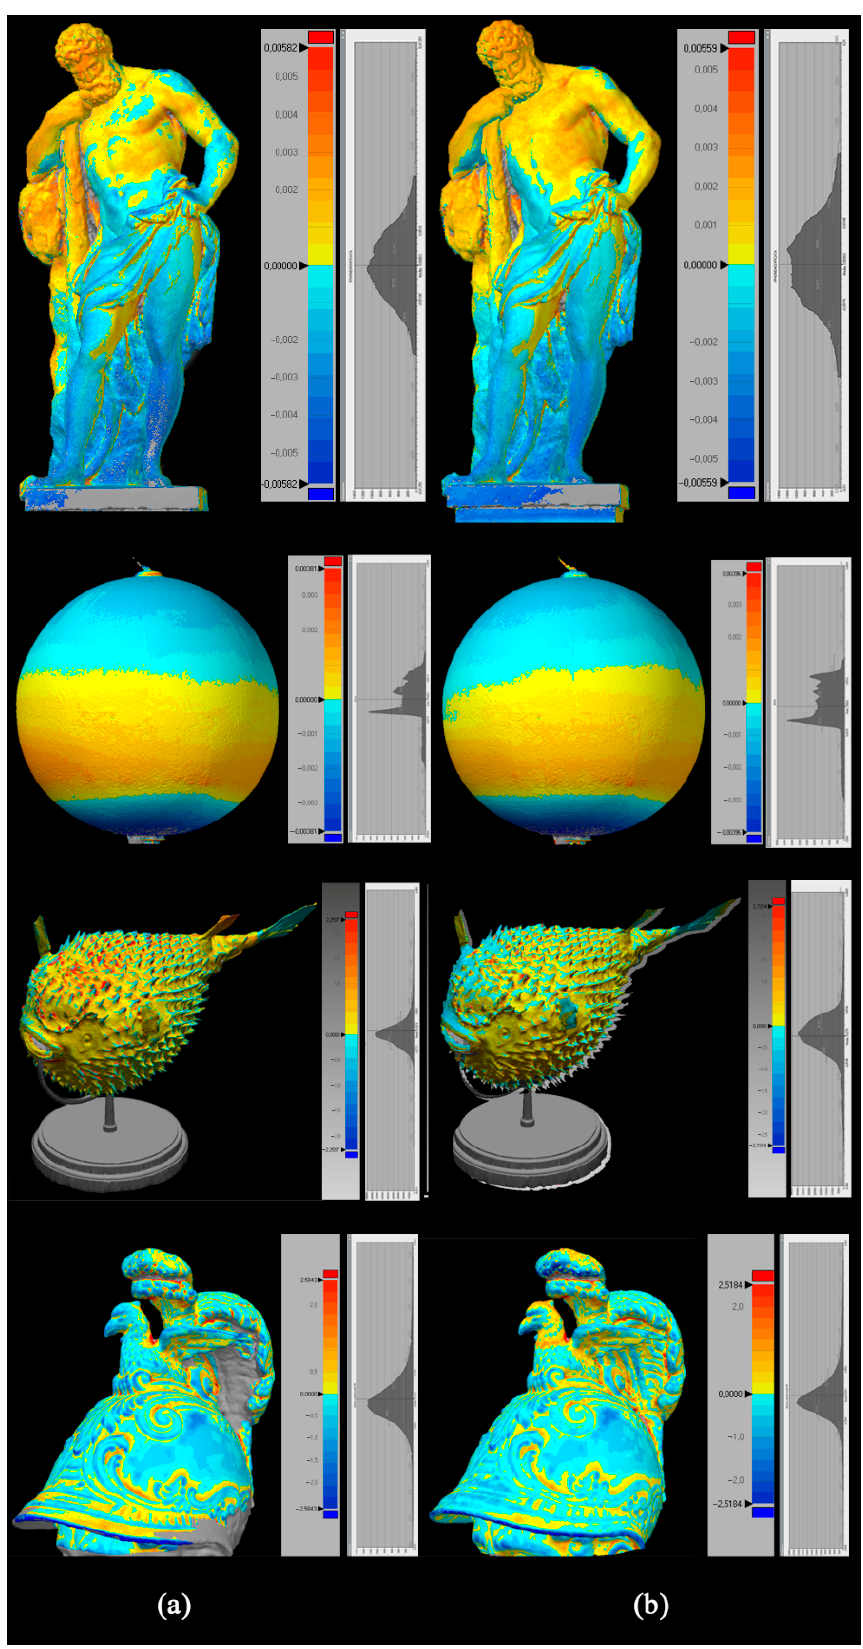
Figure 23. False-color maps and distribution distance diagrams of dense point cloud comparison: iPhone X vs. Ground truth ( a ); iPhone X vs. Nikon D5200 ( b ).